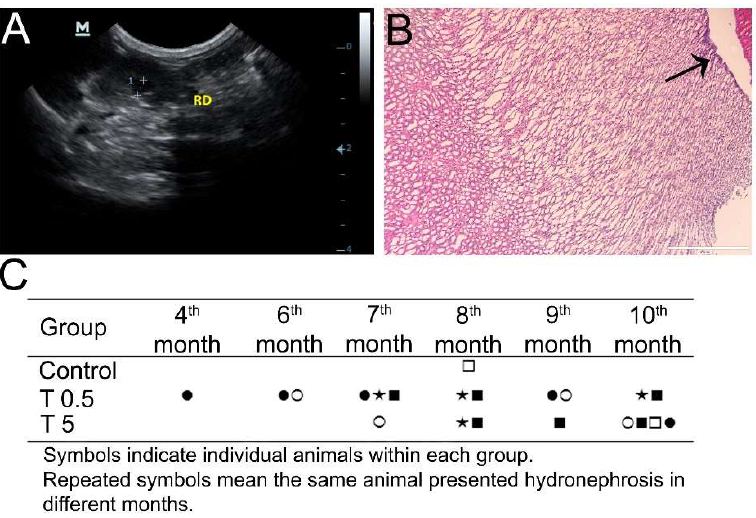
Figure 4. ( A ) Ultrasonographic image of a T0.5 Group animal kidney, with hydronephrosis (dilated pelvis shown between the two crosses). ( B ) Histopathological image of a T5 Group animal kidney showing a finding consistent with hydronephrosis (arrow shows the dilated pelvis), but without renal parenchyma damage (10 × magnification, scale bar = 400 µ m). ( C ) Hydronephrosis observed by ultrasound examination in experimental animals from both treated groups and the Control at different timepoints .